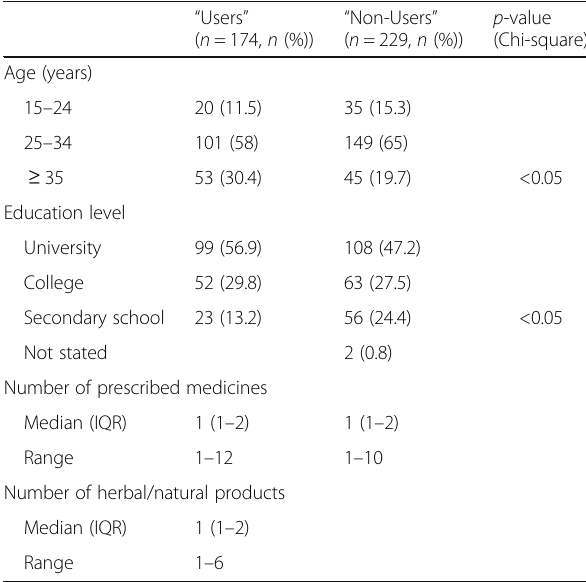
Table 1 Demographics of women reporting concurrent use of prescription medicines with herbal and natural products (Users) and women reporting prescription medicine use only